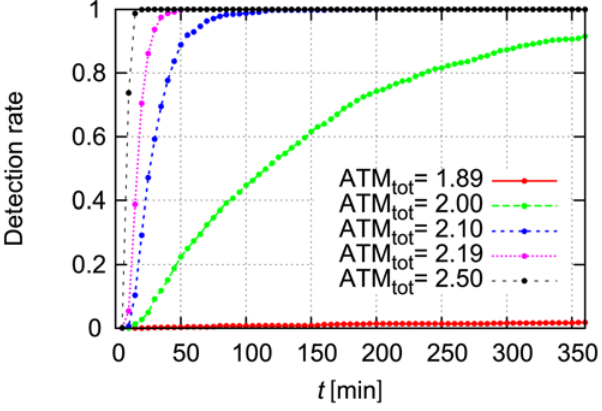
Figure 8. The time to detection of DSBs decreases as the total concentration of ATM increases. The detection rate denotes the fraction of sample paths which pass through the threshold T ATM (cid:2) at time t . The rate constants are j ATM ~ 0 : 78 and k DSB ~ 0 : 0023 . Other parameters are as defined in Table 1. Initial numbers of molecules are X